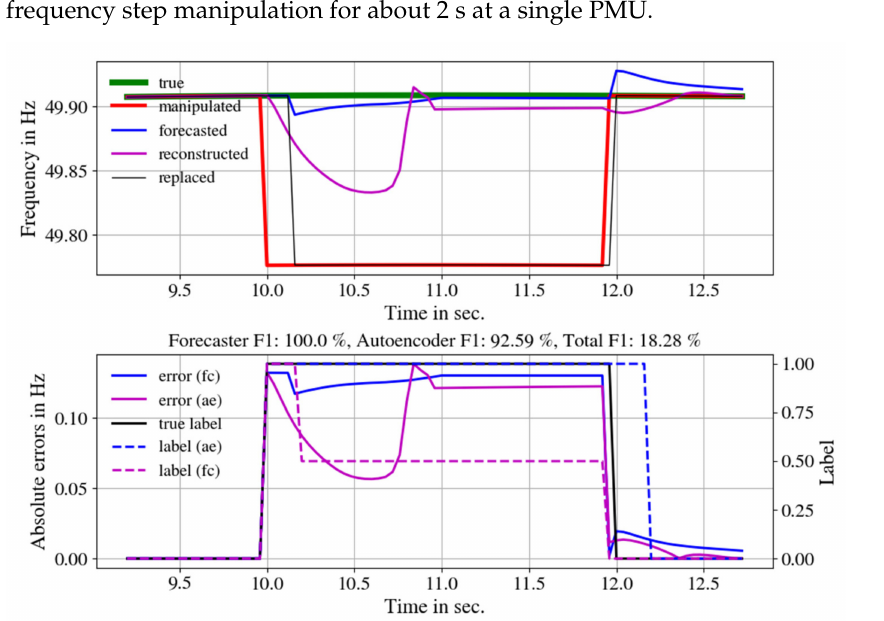
Figure 13. Exemplary results of the GRU-AE and GRU-FC models for a frequency step